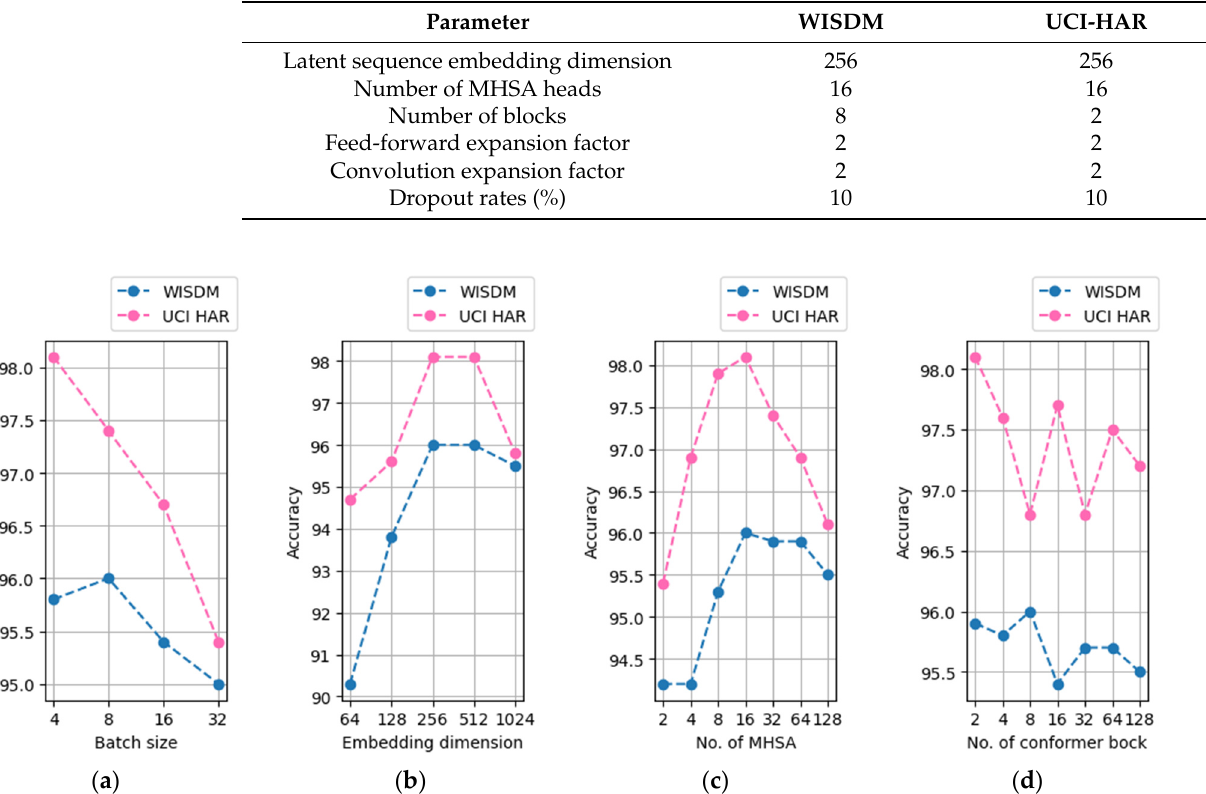
Figure 3. Optimal hyperparameters and batch size of the model; ( a ) accuracy according to batch size; ( b ) accuracy according to latent sequence embedding dimension; ( c ) accuracy according to the number of MHSA; and ( d ) accuracy according to the number of conformer block.